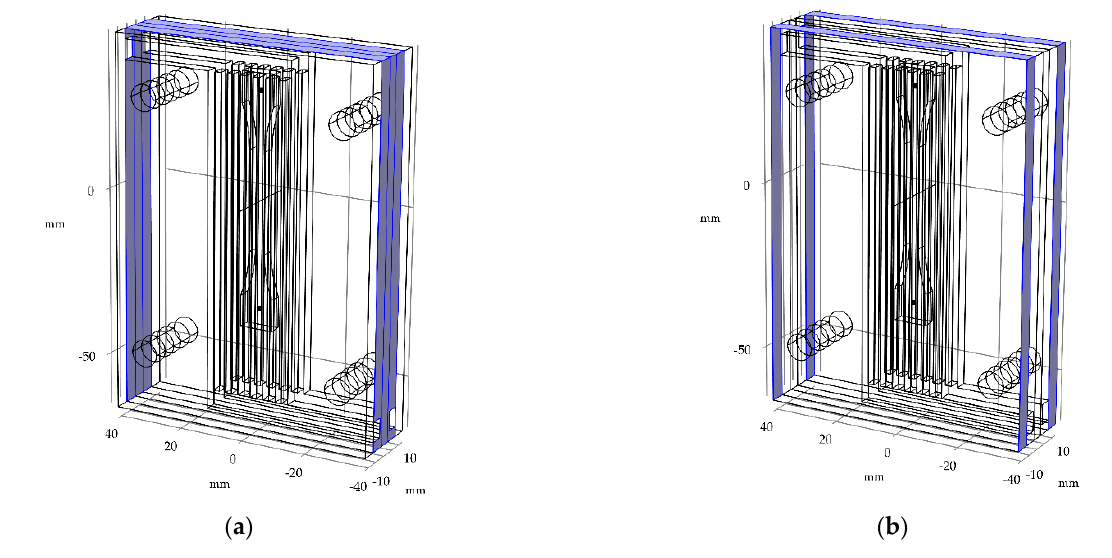
Figure 9. The surface emissivity: ( a ) the wax injection mold heat radiation surfaces, ( b ) the PMMA heat radiation surfaces.